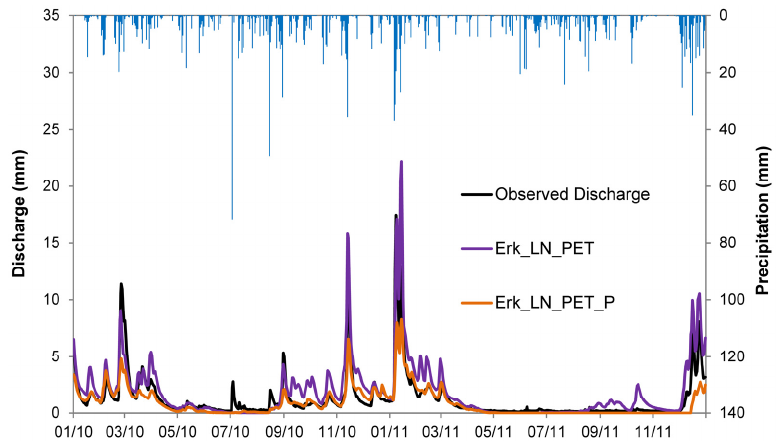
Figure 7. Observed and simulated discharge of the Erkensruhr for simulations with homogeneous (Erk_LN_PET) and distributed precipitation (Erk_LN_PET_P). Water 2016 , 8 , 202 15 of 22